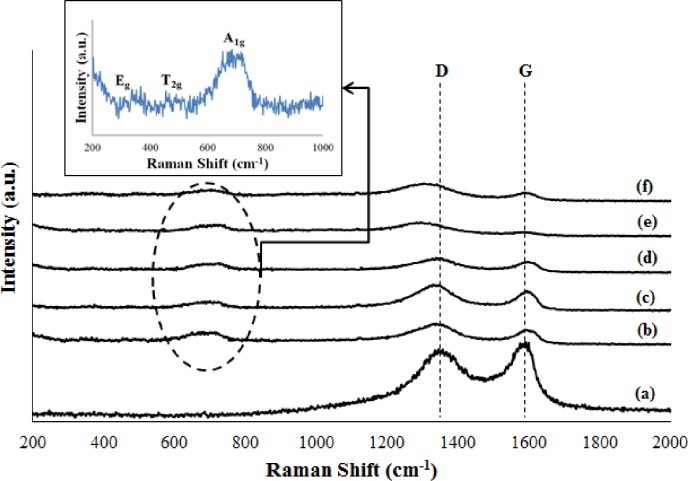
Raman spectra of (a) GO, (b) M-rGO3, (c) M-rGO6, (d) M-rGO12, (e) M-rGO18 and (f) M-rGO24. The inset shows the close view of the representative Raman spectrum (M-rGO3).